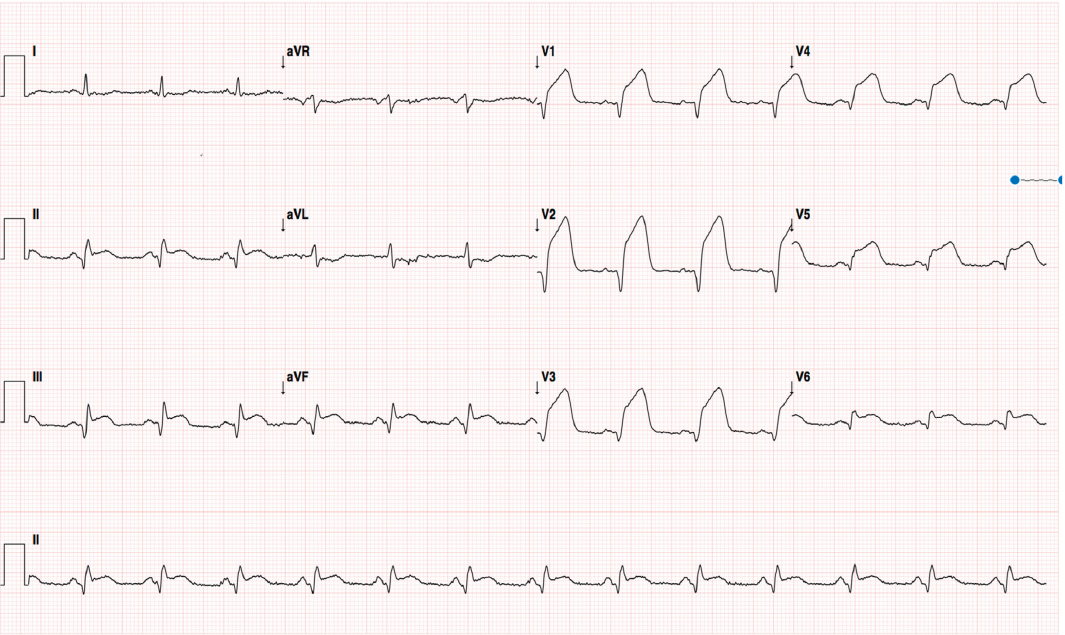
Figure 1: Admission